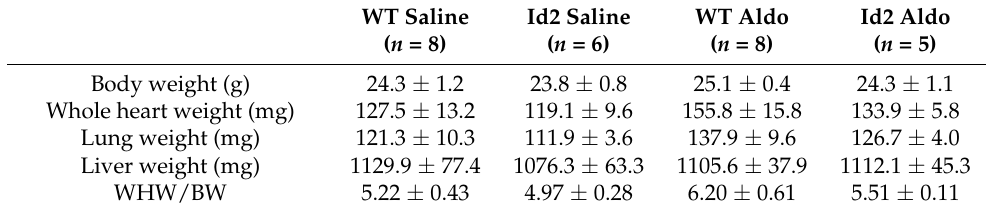
Table 2. Physiological characteristics of mice 1 week after saline and aldosterone infusion.